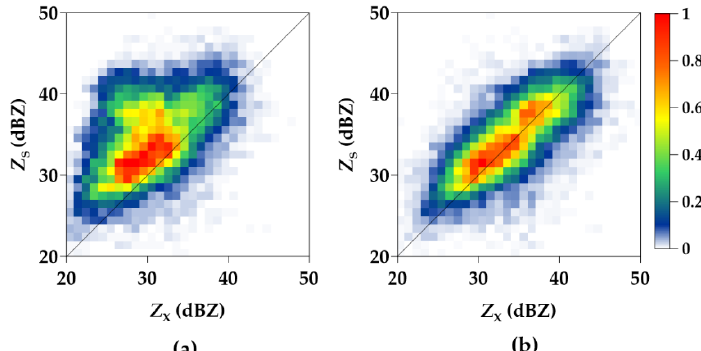
Figure 8. Frequency plots of X band reflectivity ( Z X ) before and after rain attenuation correction vs. observed S band reflectivity ( Z S ): ( a ) before the correction and ( b ) after the correction by dynamic RIC. The other frequency plots of rain attenuation correction are similar to ( b ) and are omitted here; such are static RIC (a rain event) or static RIC (an hour) and an empirical DP relation.